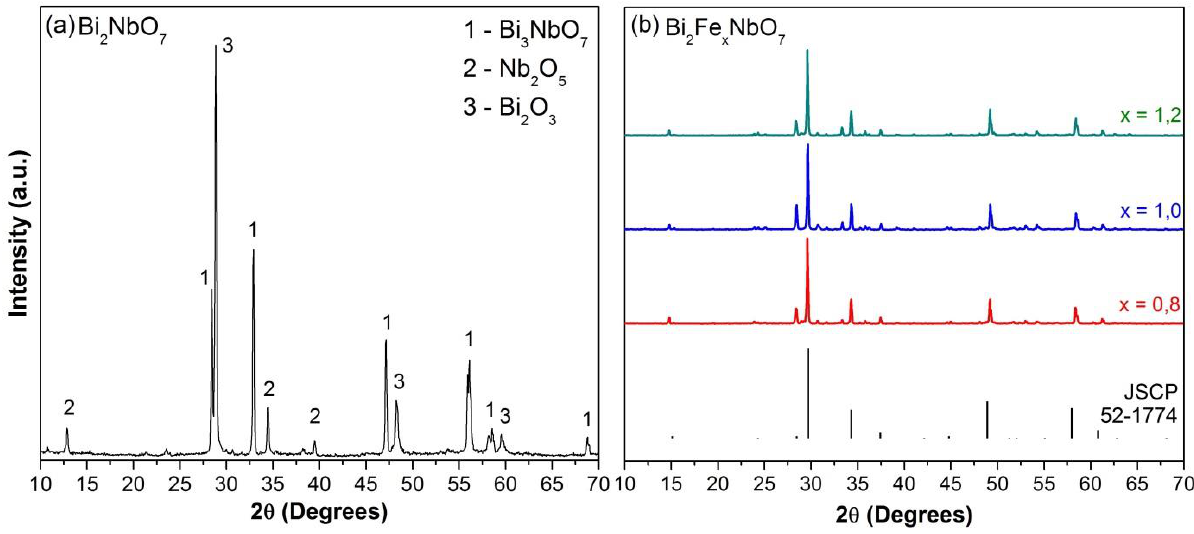
Figure 3. XRD patterns of the catalysts annealed in 900°C, (a) Bi 2 NbO 7 and (b) Bi 2 Fe x NbO 7.